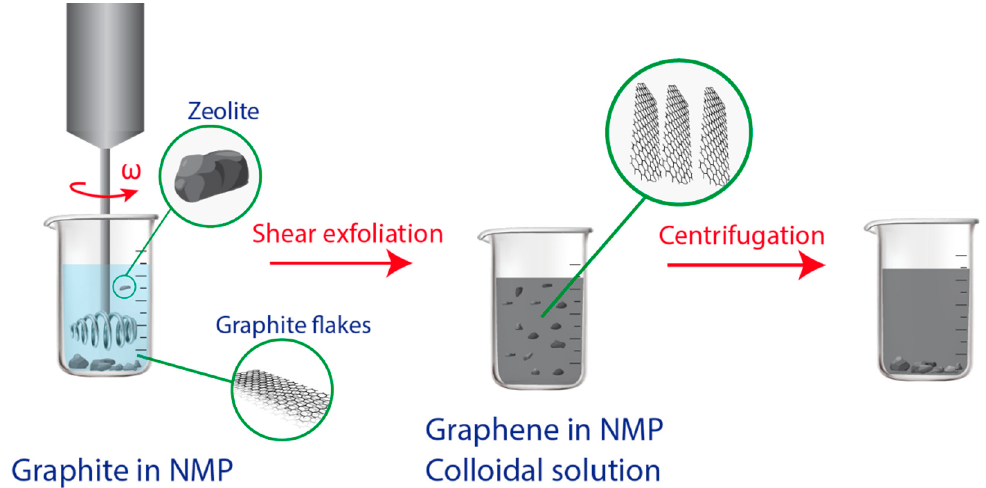
Figure 1. Schematic route of the preparation process for graphene dispersion.